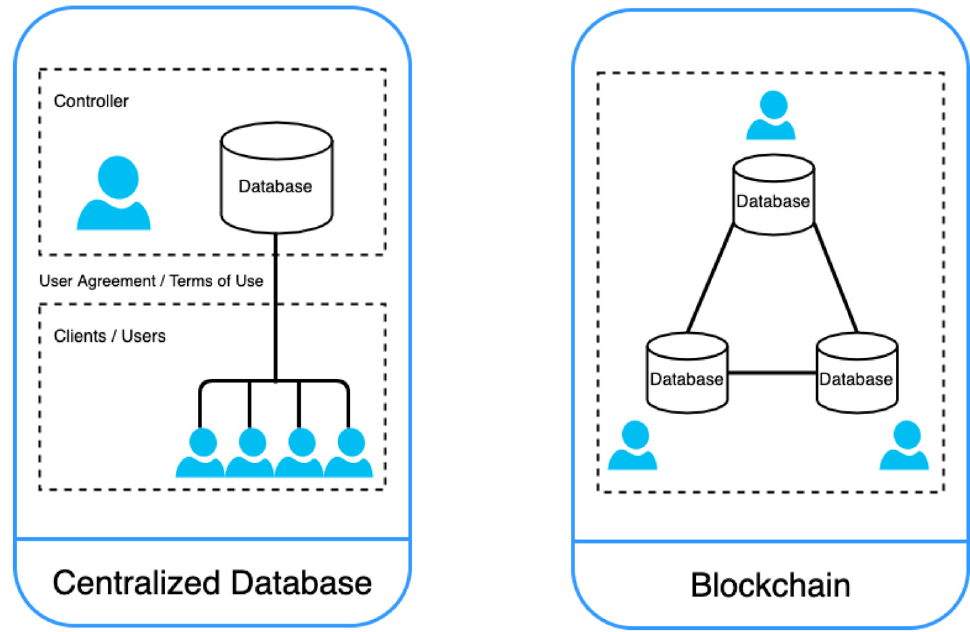
Fig. 3. Centralized solution and